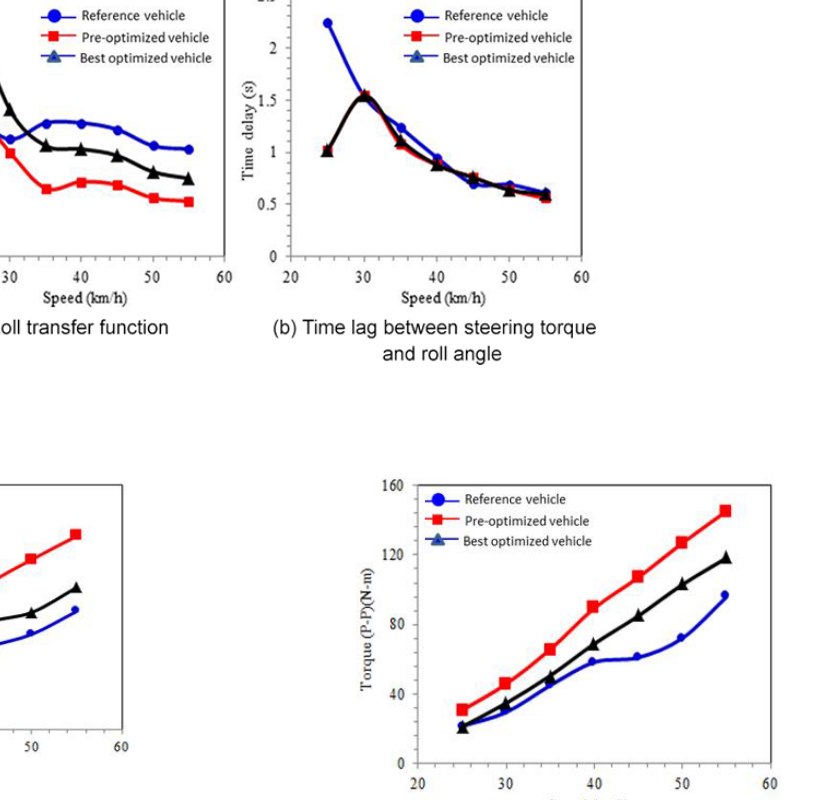
Figure 26. Simulated steering torque of the lane change.